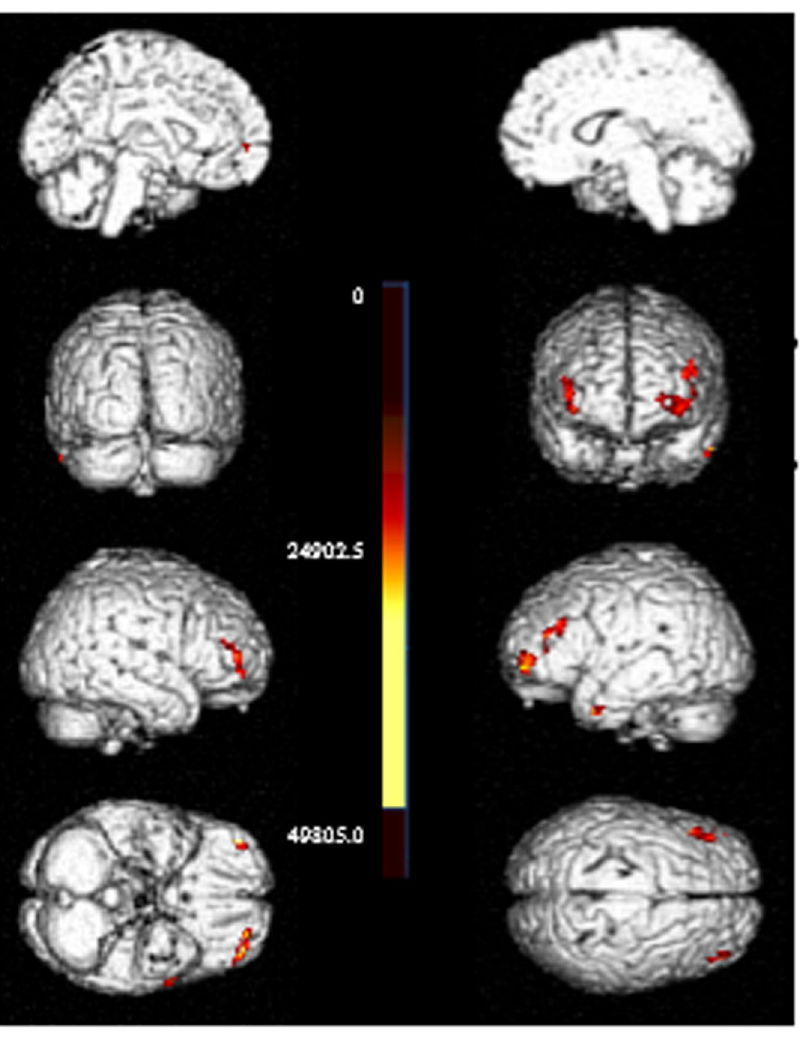
Figure 3. PET analysis of FFI patients. PET image for Patient 2 indicating reduced glucose metabolism in the bilateral frontal and parietal lobes and left thalamus.